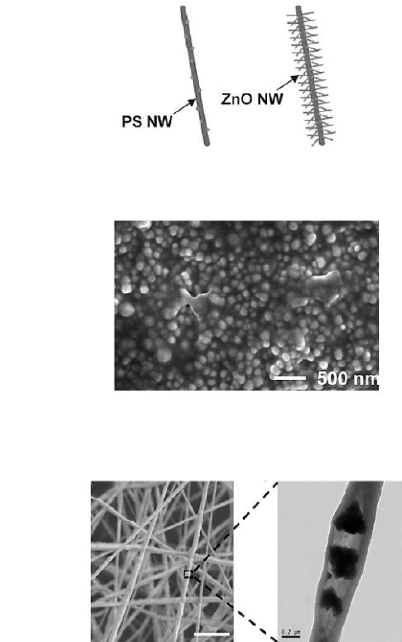
Figure 4. Material innovation: nanocomposite materials. ( a ) SEM image of a sensor based on ZnO / PS NWs. Copyright from John Wiley and Sons. ( b ) SEM image of a sensor based on BaTiO 3 / PDMS. Copyright from Elsevier. ( c ) SEM image of a sensor based on ZnO / PVDF. Copyright from Elsevier.